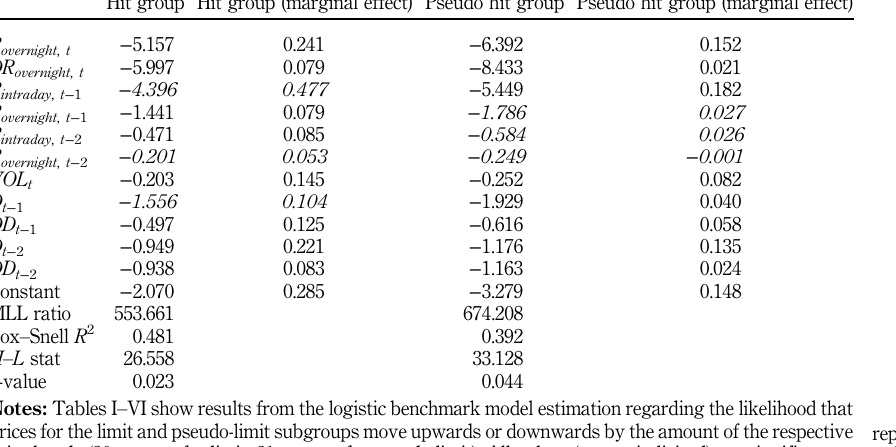
Table V. Logit regression report on likelihood of lower floor hit